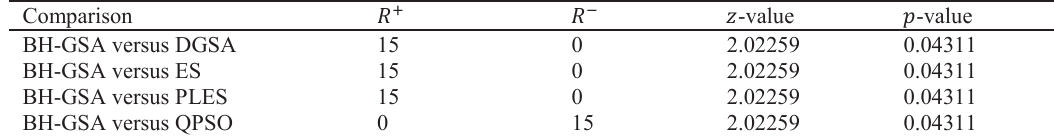
Table 15. Wilcoxon signed ranks test results for unimodal test functionsof set 2.